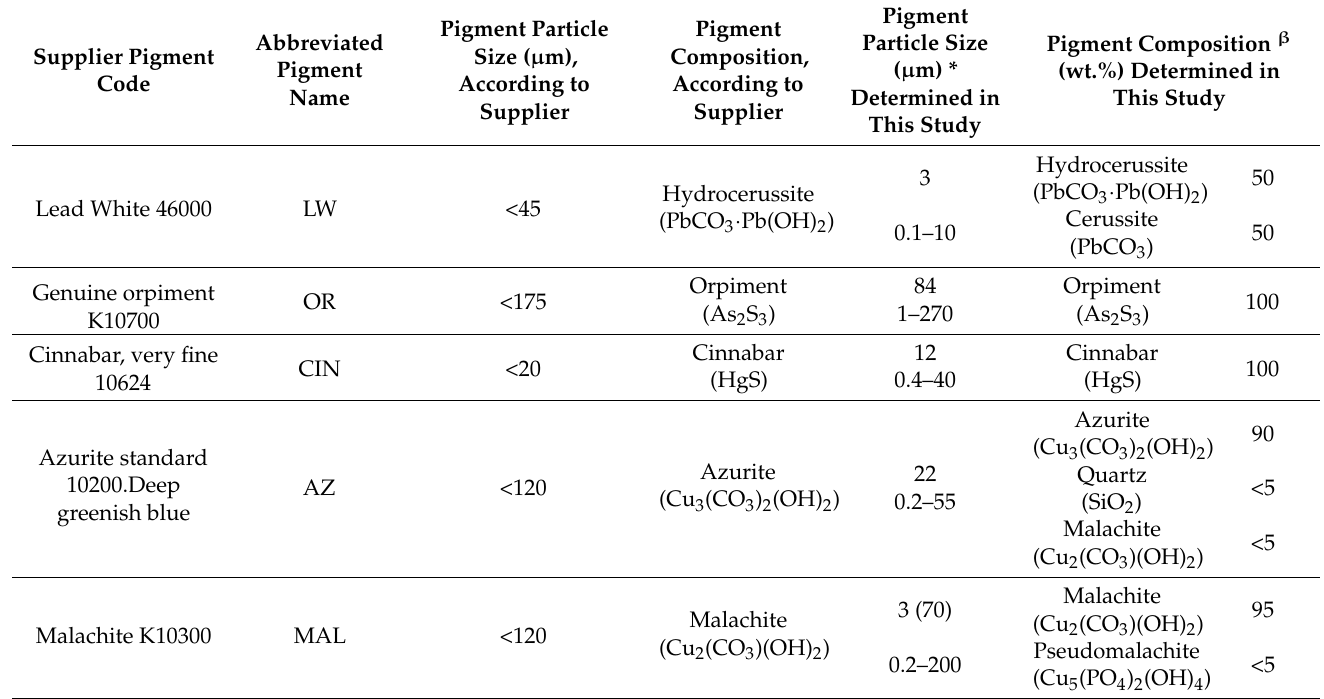
Table 1. Properties (particle size and mineralogical composition) of the powdered pigments according to the supplier and determined in this study. The abbreviations of the names of the different pigment are also